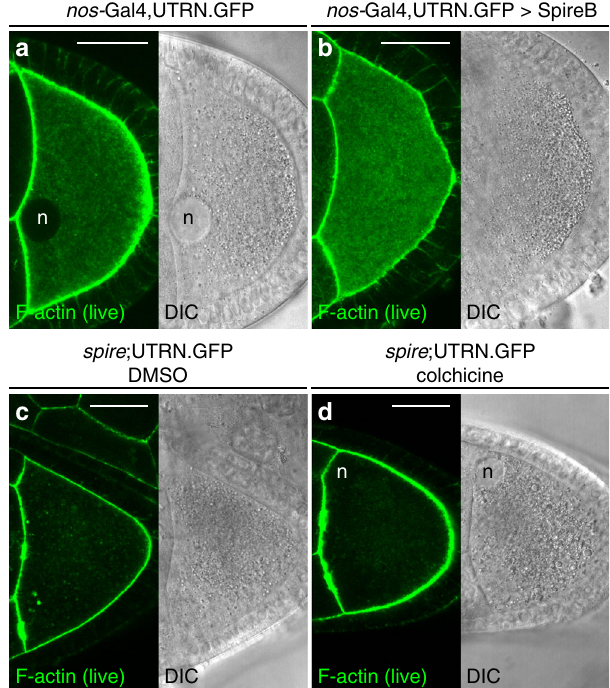
Fig. 4 Cytoplasmic F-actin is the major source of active diffusion. a Living control egg chambers or b egg chambers over-expressing the actin nucleator SpireB. Overexpression of SpireB causes an increase in the amount of F-actin in the oocyte (see also Supplementary Fig. 4). c , d spire mutant oocytes were incubated in control DMSO-containing medium ( c ) or in colchicine-containing medium d . As expected, spire mutants do not form an actin mesh. Scale bar is 30 µ